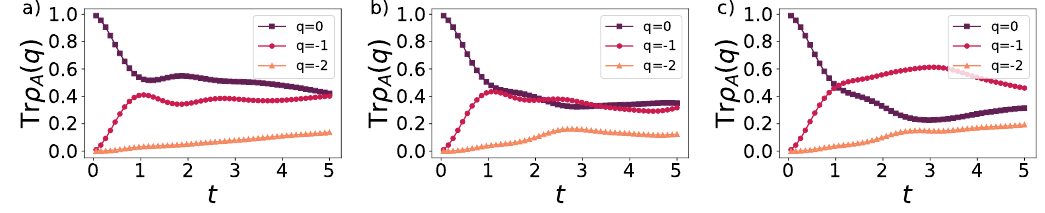
Figure 10: Population of the symmetry sectors during the evolution of the system described in Fig.6, starting from state |↓↑〉 and we take A = [ 1,2,3,4,5,6 ] and B = [ 7,8,9,10,11,12 ] . Panel a) w = 1, m = 0, = 0; b) w = 1, m = 0, J = 0.1, ε J = 1, ε 0